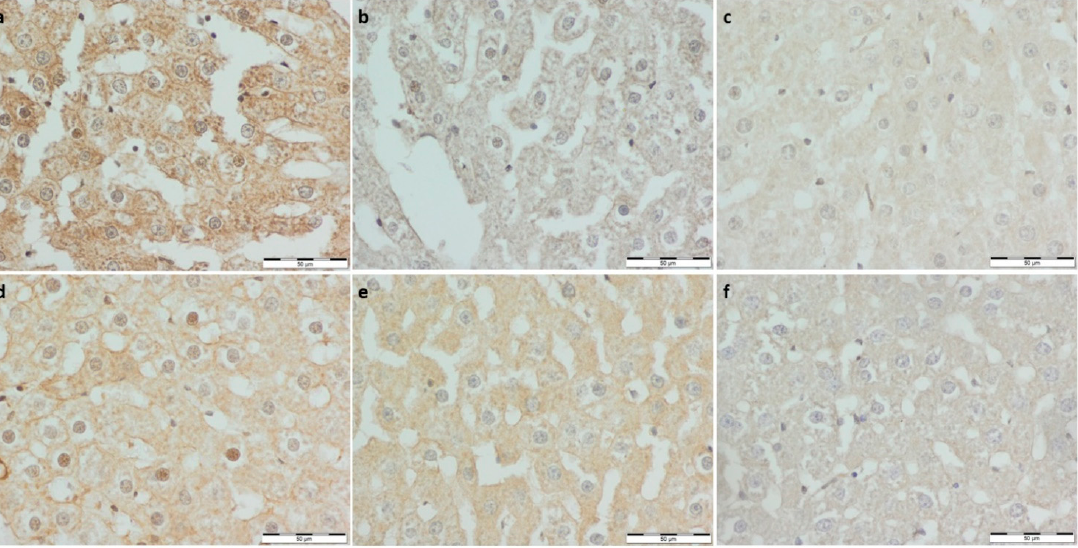
Figure 4. ( a ) Con-Sed, ( b ) Con-Run, ( c ) WP-Sed, ( d ) BP-Sed, ( e ) WP-Run and ( f ) BP-Run; immuno- stainings against eNOS (NOS3); Significantly greater eNOS optical density score was noted in the running control group than non-running. eNOS expression was the highest in the Con-Run group. The BP-Sed group had significantly lower expression of eNOS than the Con-Sed group. Bee pollen supplemented groups had lower eNOS expression than corresponding controls.